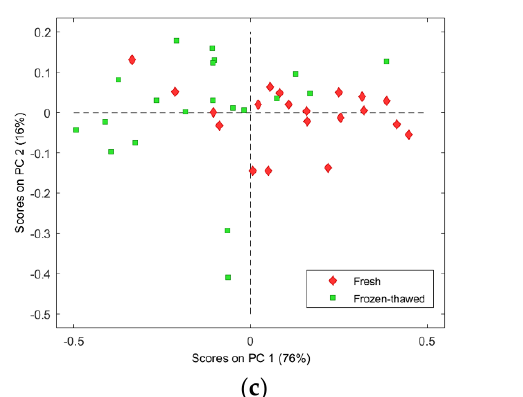
Table 2. An overview of the accuracies of the PLS-DA models with various pre-processing techniques applied to distinguish between fresh or previously frozen meat.